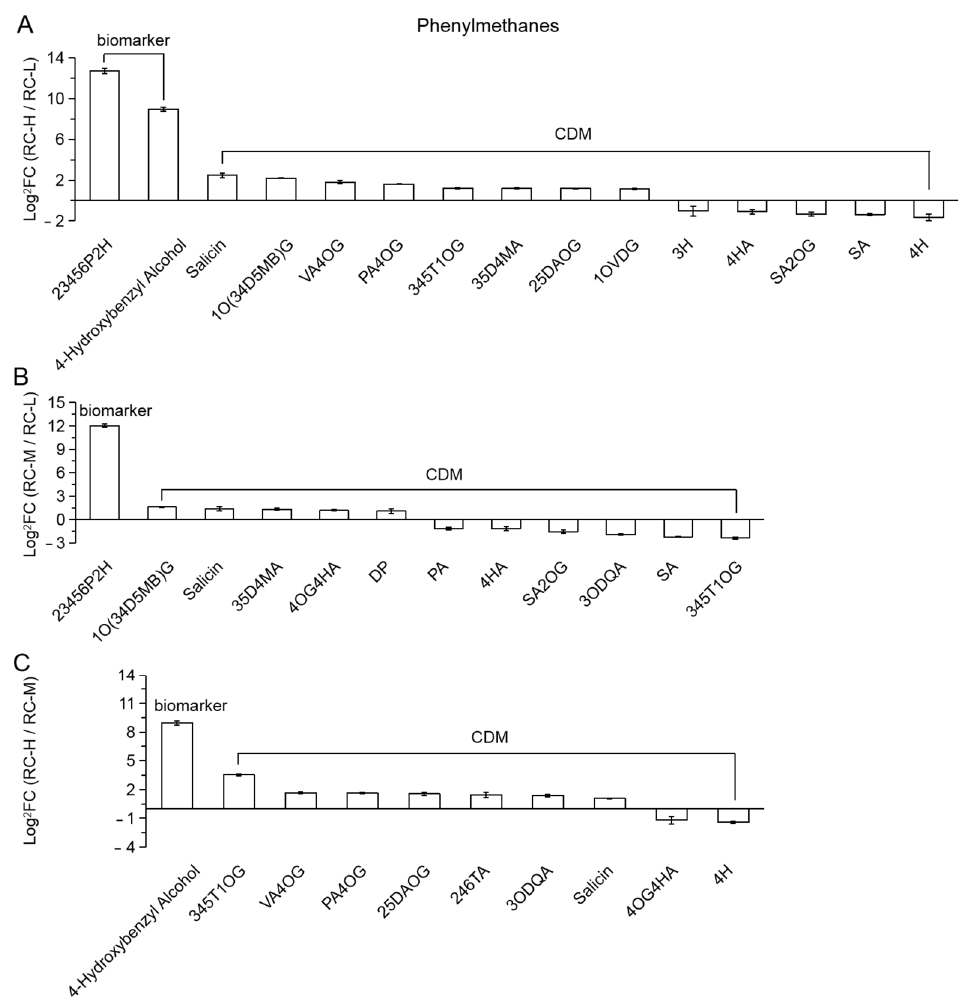
Figure 13. Comparison of differential metabolites of phenylmethanes between RC-L, RC-M and RC-H. These were 2 biomarkers and 13 CDMs for RC-H vs. RC-L ( A ), 1 biomarker and 11 CDMs for RC-M vs. RC-L ( B ), and 10 CDMs for RC-H vs. RC-M ( C ). Upregulation denotes that the content of a metabolite in RC increased with elevation between two altitudes, and the opposite for downregulation. The Y-axis is shown as Log 2 FC values for the convenience of visual presentation (Note: The up-amplitude in the text refers to the FC value). The X-axis denotes metabolite names.